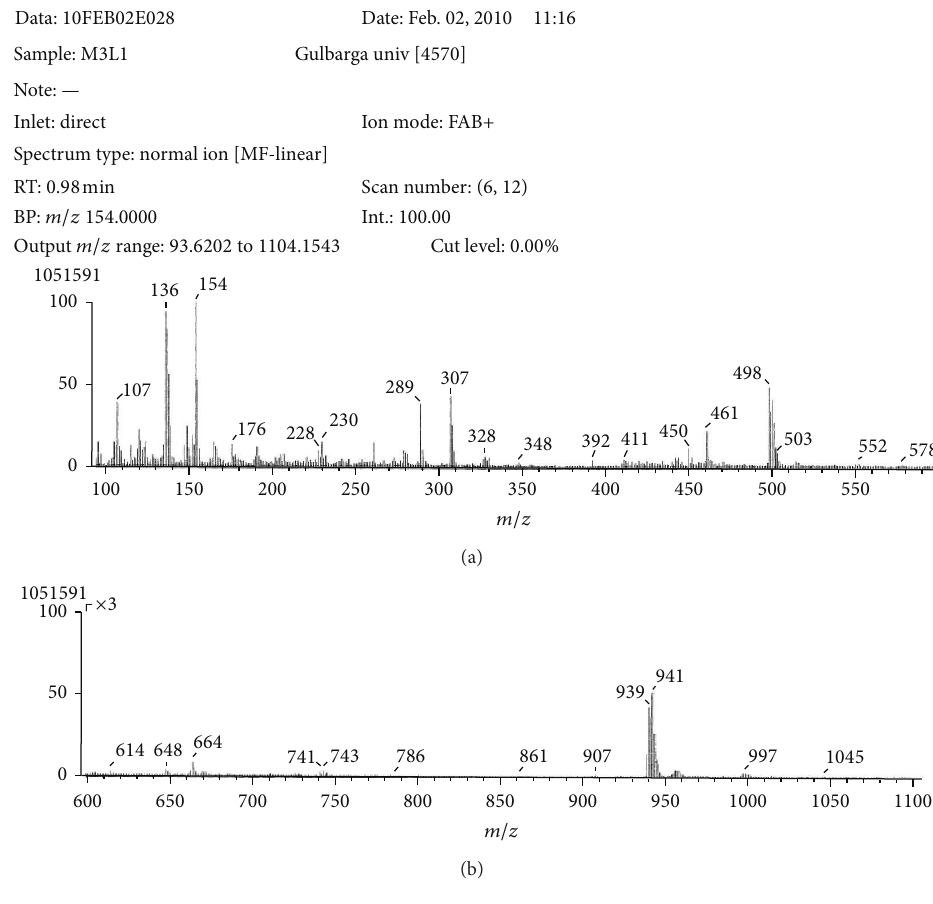
Figure 1: FAB-mass spectrum of Ni(II) complex. Table 4: Electronic spectral bands and ligand field parameters of the Co(II), Ni(II), and Cu(II) complexes in DMF (10 − 3 M) solution. Complexes